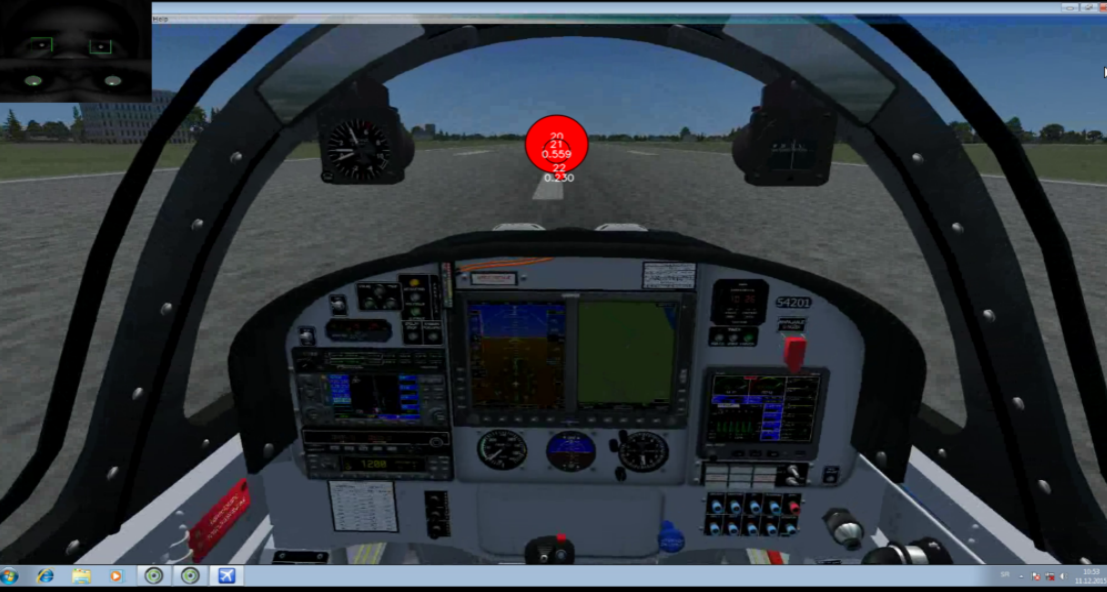
Figure11. Recording of participant P7 Take off phase. Gaze plot of 3 seconds duration. Fixation (Red circles) of evi- dently larger radius and thus longer duration. Saccades from AOI ‘AST’ to AOI ‘OC’ (or vice versa) not